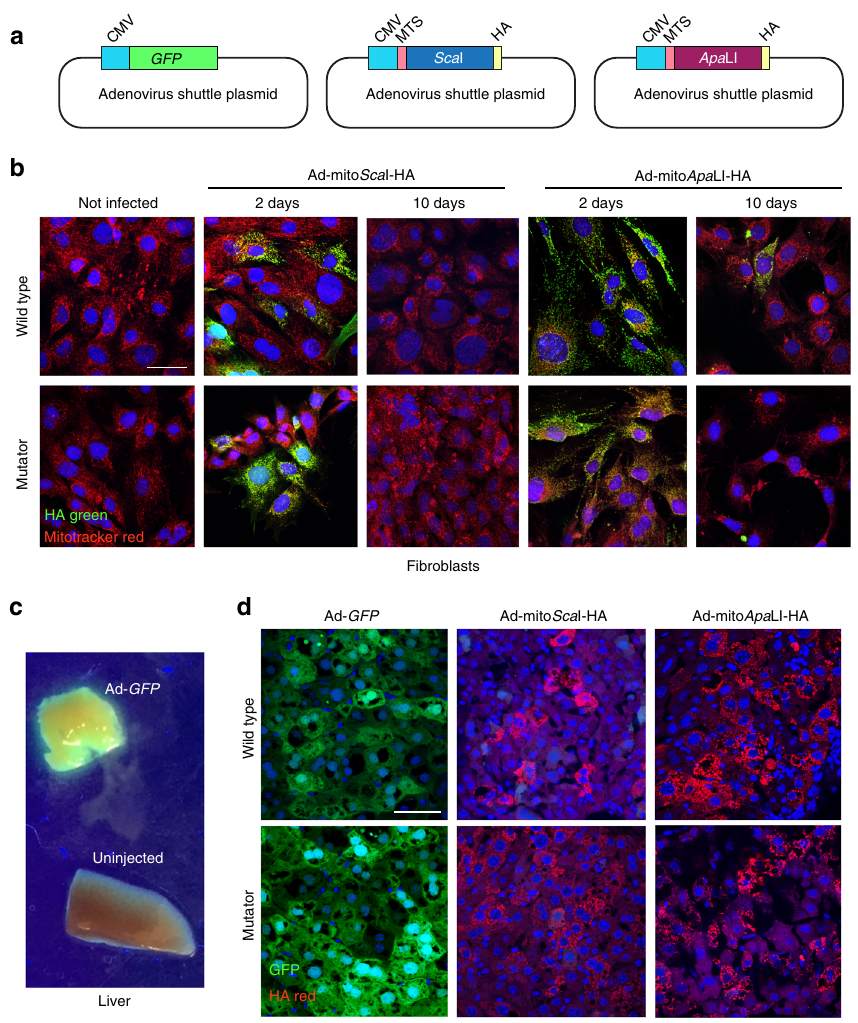
Fig. 1 Expression of mitochondrial-targeted restriction endonucleases in the mutator mouse. a Diagrams illustrating the basic gene components of the plasmids used to make adenoviral particles. b Lung fi broblasts from wild-type and mutator mice were established as described in methods. Fibroblasts were infected with adenovirus expressing mito Sca I-HA or mito Apa LI-HA restriction endonucleases. Fibroblasts were stained with Mitotracker Red and fi xed after 1, 2, 5, and 10 days. See Supplementary Fig. 1 for days 1 and 5. Fibroblasts were immuno-stained for HA. Scale bar = 50 μ m. c C57BL6/J mice were injected with adenovirus expressing GFP. After 5 days mice were killed and livers exposed to UV light. d Mutator and wild-type mice were injected with adenovirus expressing GFP, mito Sca I-HA or mito Apa LI-HA. After 5 days mice were killed and the livers removed and subjected to immunostaining for HA. Scale bar = 50 μ